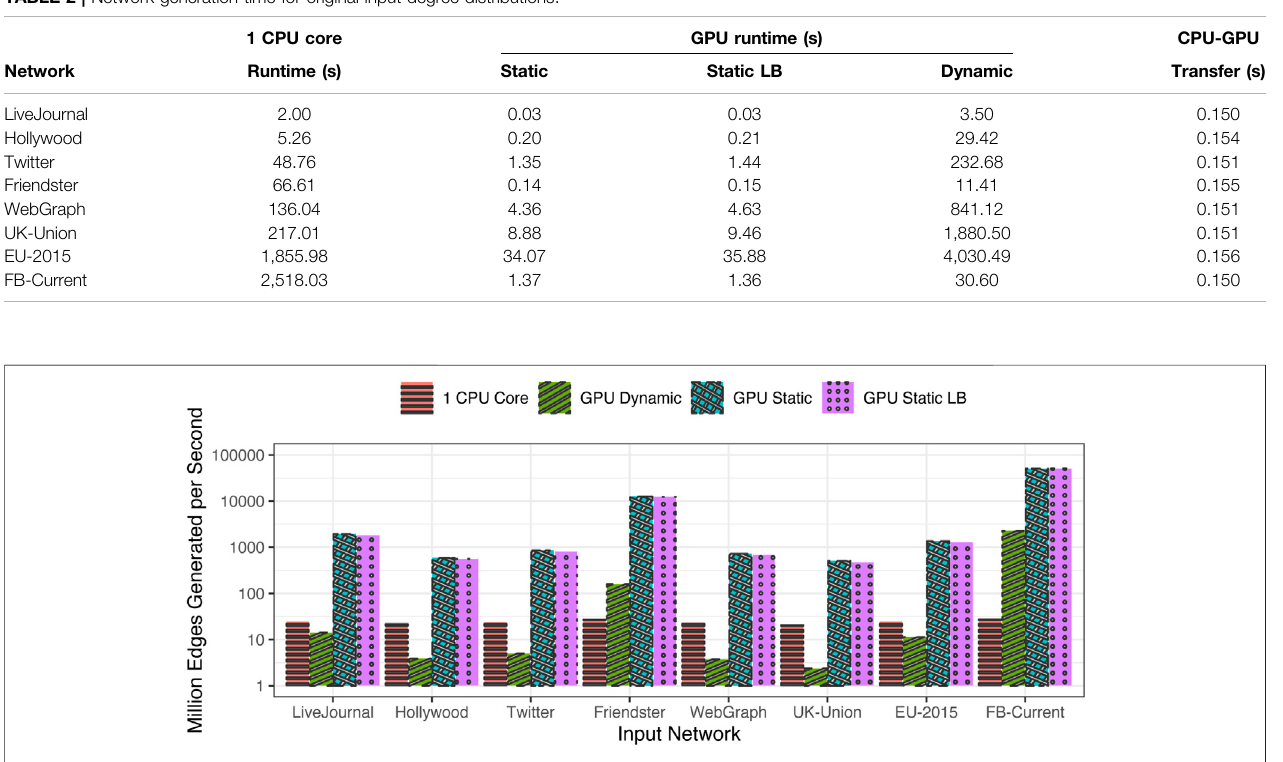
FIGURE 5 | Speed of generation (million edges generated per second) for the original input distributions.